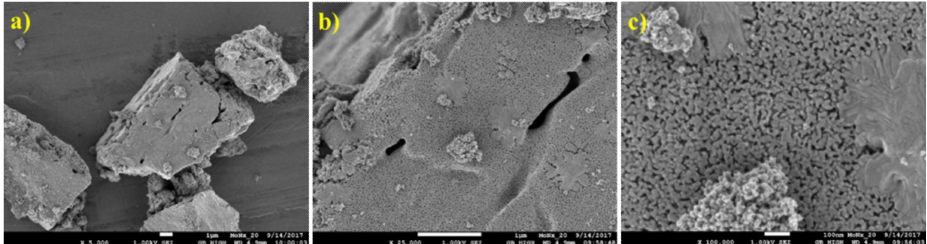
Figure 13. SEM images of HMT-AHM-700 in different magnifications: ( a ) 5000 × , ( b ) 25,000 × , and ( c ) 100,000 × .